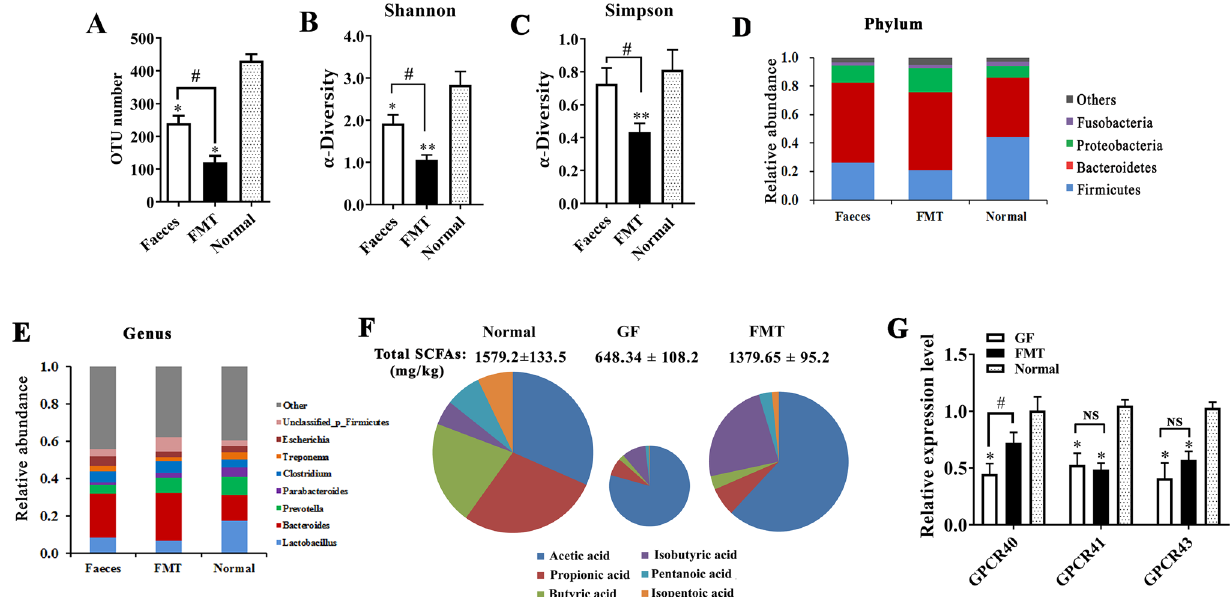
Figure 2. Colonization of the intestinal microbiota in GF piglets by FMT. ( A ) Operational taxonomic unit (OTU) number of gut bacteria in the colon digesta of piglets. ( B ) and ( C ) α-Diversity of intestinal bacteria. ( D ) and ( E ) Bacterial composition of the different communities at the phylum level and genus level. ( F ) The content of short-chain fatty acids (SCFAs) in the colonic content of the piglets. ( G ) Expression levels of G-protein- coupled receptors (GPCRs). mRNA expression was determined by qPCR in the colonic wall. N = 3, the data are presented as the means ± s.e.m. * P < 0.05, ** P < 0.01 compared to the normal piglets (control). # P < 0.05, ## P < 0.01 between the GF piglets and FMT piglets. SCFAs short-chain fatty acids, NS not significant, GF piglets germ-free piglets, FMT piglets GF piglets with fecal microbiota